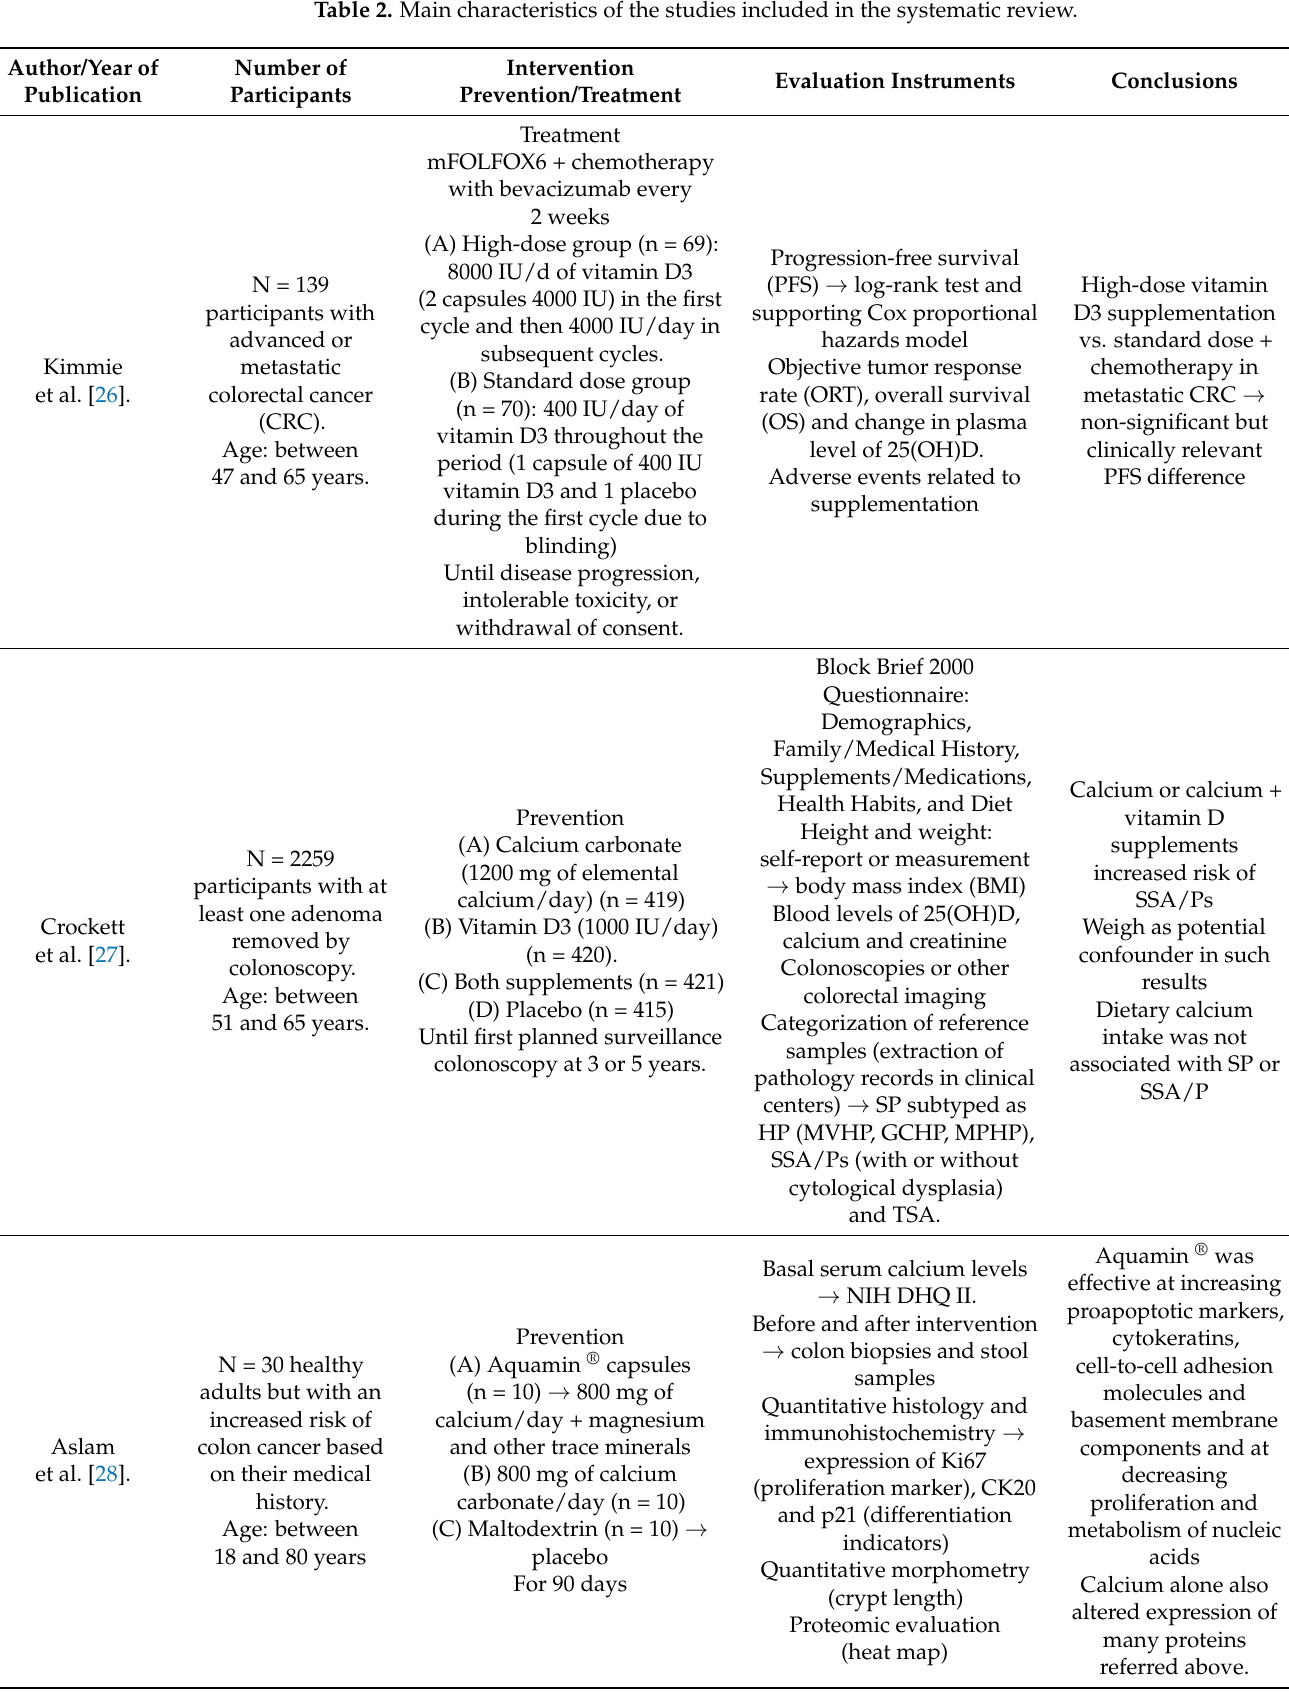
Table 2. Main characteristics of the studies included in the systematic